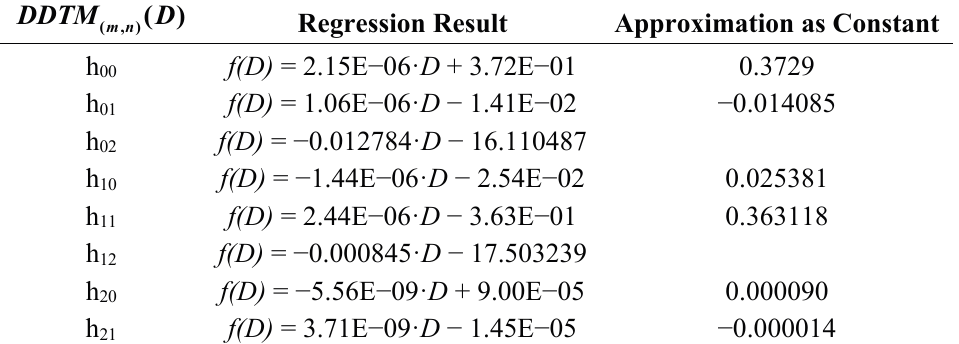
Table 3. DDTM regression summary for the sensor configuration used in our